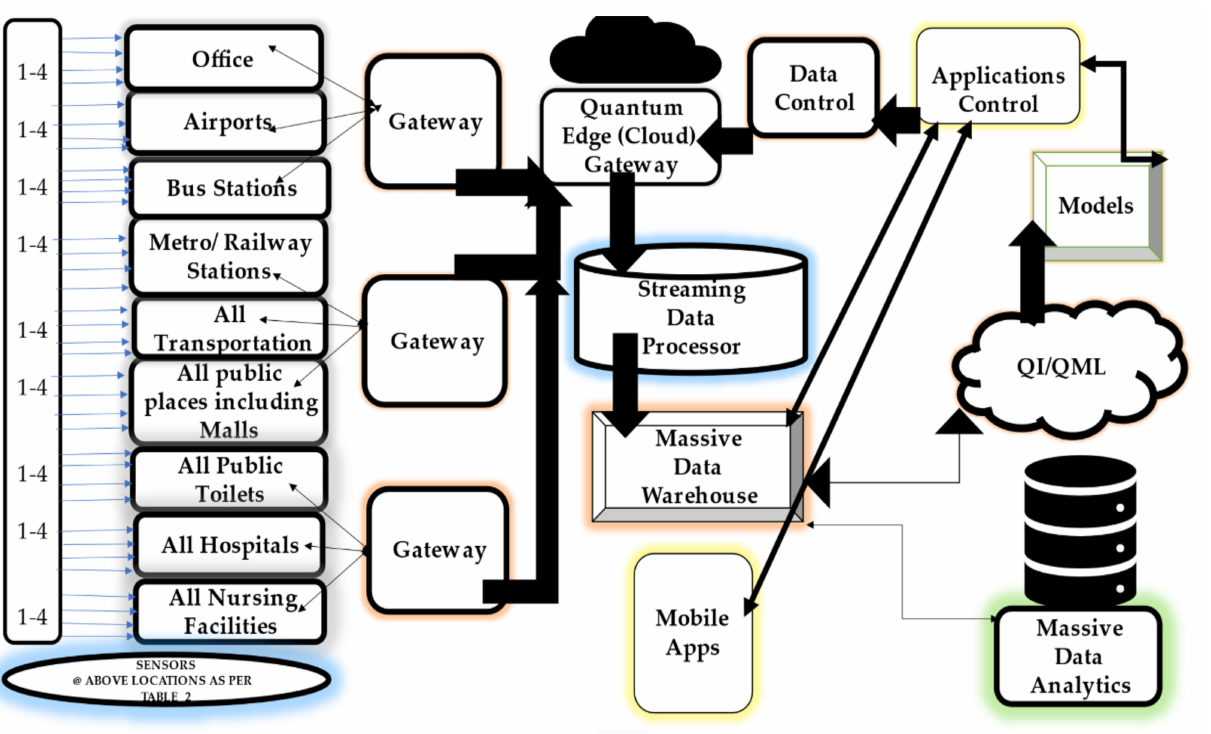
Figure 9. IoT applications in the COVID-19 pandemic.